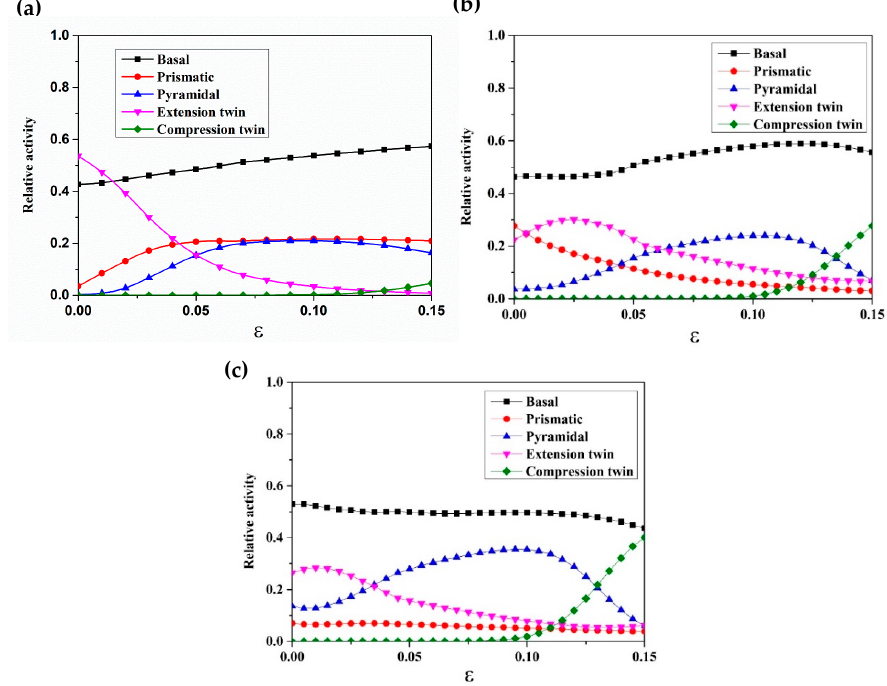
Figure 4. Predicted relative activity of deformation modes under uniaxial compression of ( a ) E0; ( b ) E45; ( c ) E90.